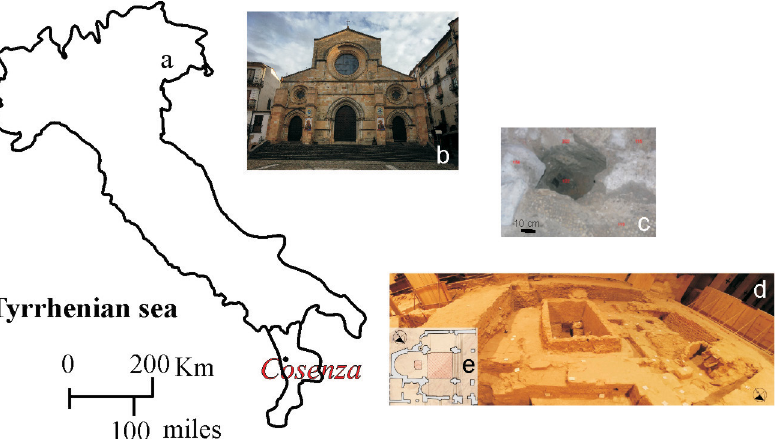
Figure 1: a ) Cosenza city in Calabria (Italy); b ) the Cosenza Cathedral; c, d ) photos of the excavations conducted in 2008; e